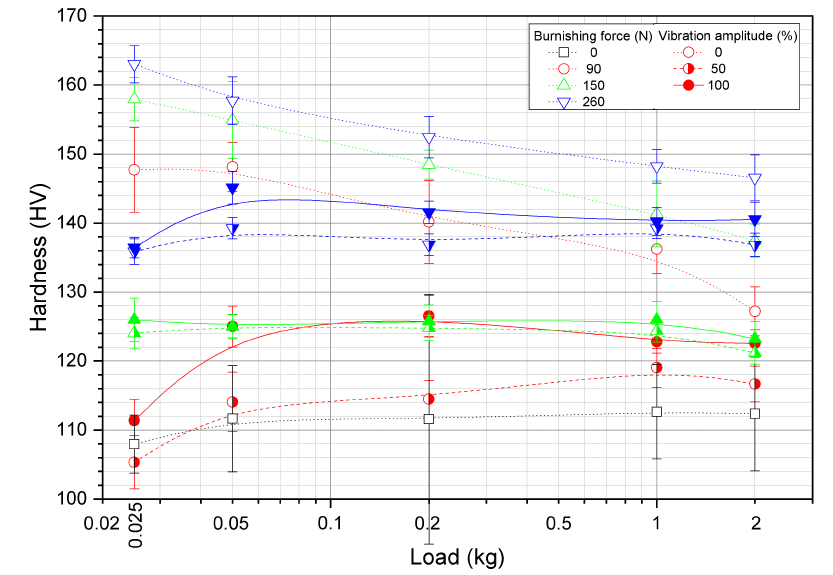
Figure 4. Vickers hardness vs. indentation load for each burnishing condition.